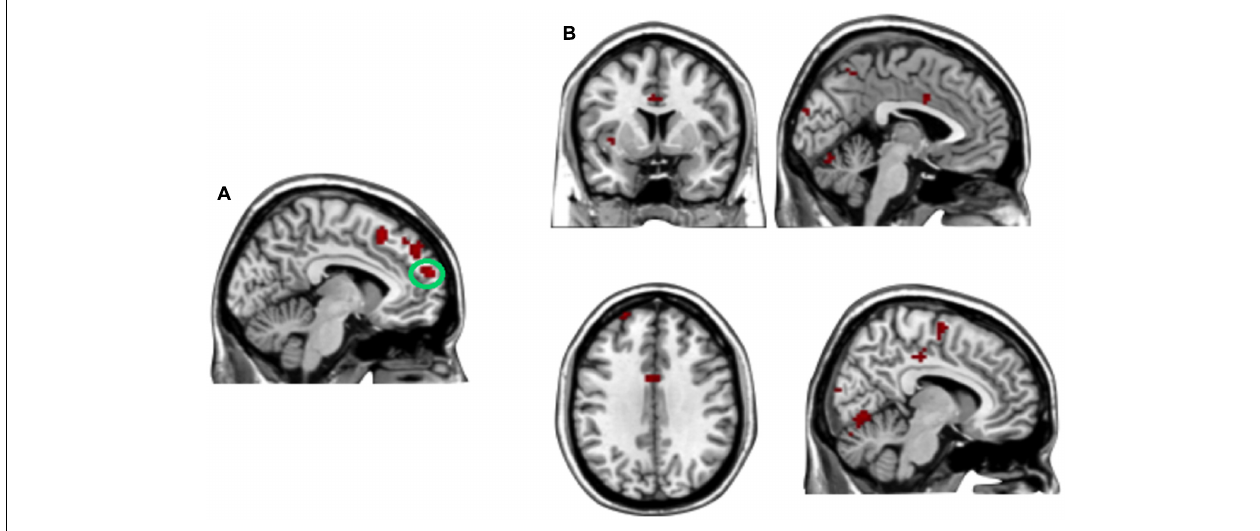
FIGURE 7 | (A) The region of interest was marked with a green circle (medial prefrontal cortex, peak at MNI coordinates: [–9, 60, 18]). (B) Results of psychophysiological interaction (PPI) analysis. Functional connectivity with the medial prefrontal cortex in the disadvantageous inequity influence effects (selfish